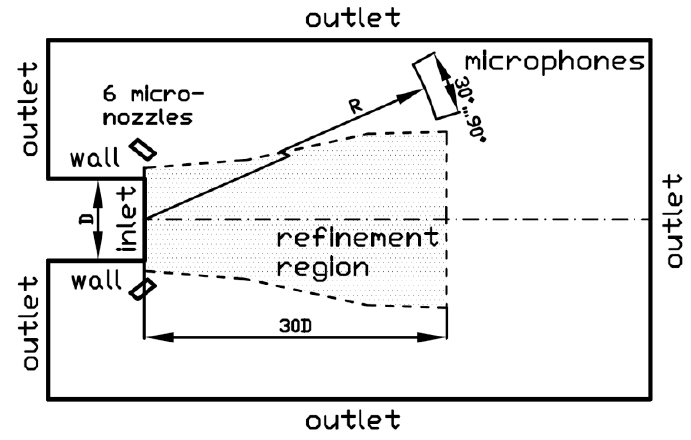
Figure 4. Computational domain and boundary conditions.